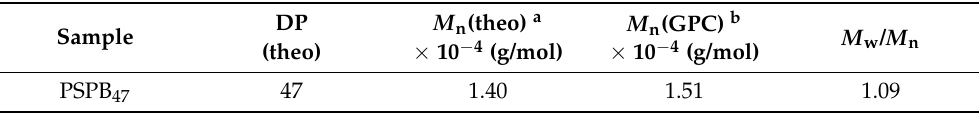
Table 1. Degree of polymerization (DP), number-average molecular weight ( M n ), and molecular weight distribution ( M w / M n